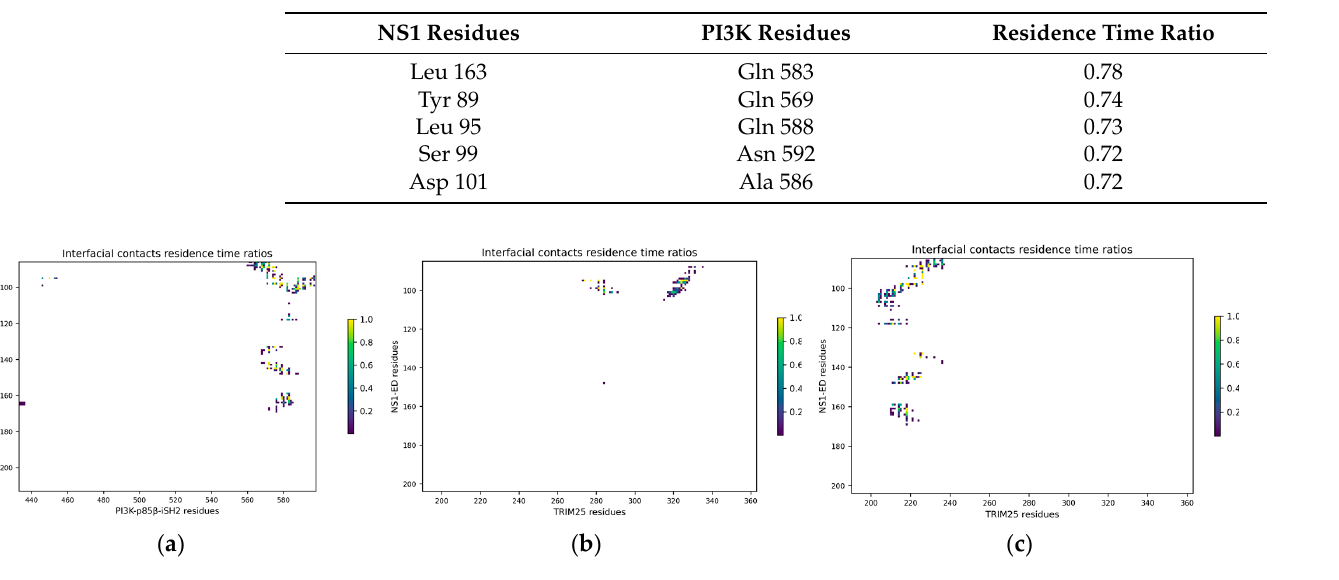
Figure 11. Intermolecular contact maps of the complexes between ( a ) NS1 and PI3K; ( b ) NS1 and the chain I of TRIM25; and ( c ) NS1 and the chain N of TRIM25. Table 3. Stable pairwise residue–residue interactions at the interface of the complex between NS1 and PI3K.